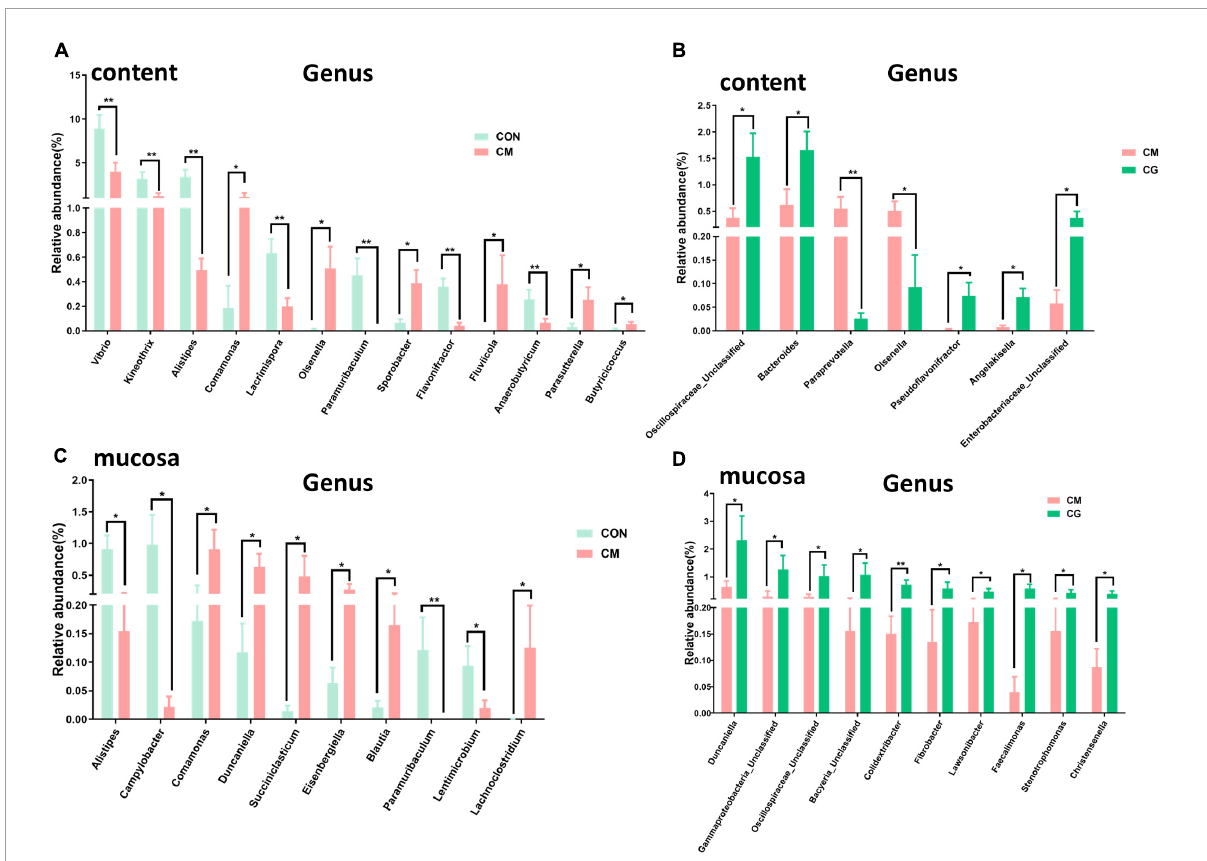
FIGURE4 Effects of low-grain fed (CON), maize meal high-grain fed (CM), and whole maize high-grain fed (CG) on the genus level bacteria in colonic content and mucosa. (A) The comparison of genus level bacterial relative abundance in colonic content between the CON and CM group. (B) The differences of bacterial relative abundance in colonic content between the CM and CG group. (C) Effects of low-grain fed (CON), and maize meal high-grain fed (CM) on colonic mucosal bacterial relative abundance. (D) The colonic mucosal bacteria respond to the maize meal high-grain fed (CM) and whole maize high-grain fed (CG). * P < 0.05 indicated that mean values were significantly difference. ** P < 0.01 indicated that mean values were greatly significantly